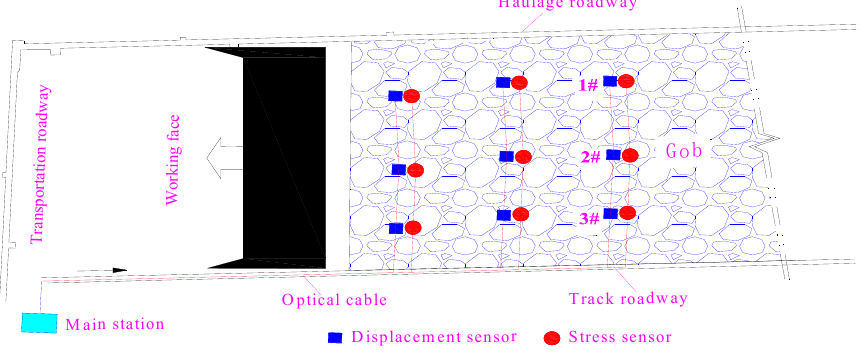
Figure 14. Sketch map of the observation equipment layout.